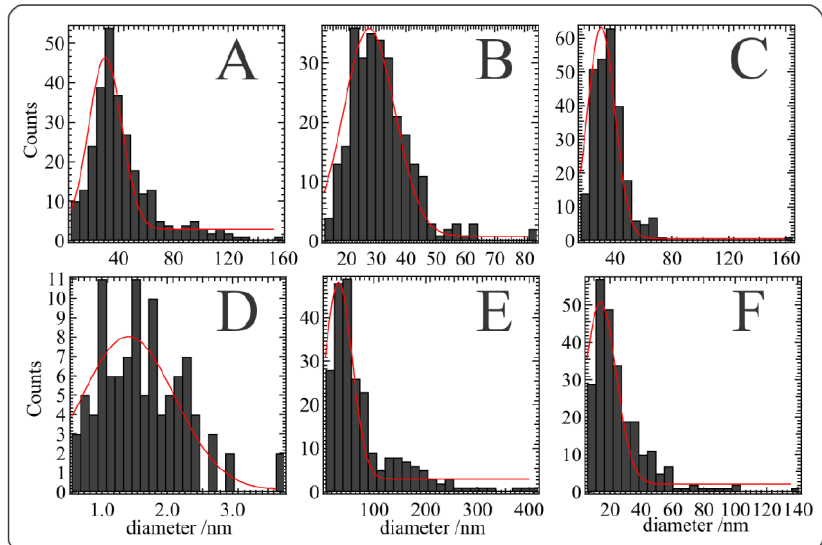
Figure 8. TEM micrographs of samples taken from the aqueous phase after one cyclic voltammetric scan performed at a 25 µm diameter w|DCE ( A – C ) or w|IL ( D – F ) interface at pH 2, 5.5 – 6, and 8.5 for the left-hand, center, and right-hand panels, respectively. [KAuCl 4 ] = 1 mM throughout; how- ever, [FcIL] = 10 ( A ), 5 ( B ), 20 ( D , E ), and 500 mM ( C , F ). ‘IL phase’ indicates residual ionic liquid surrounding the NPs.